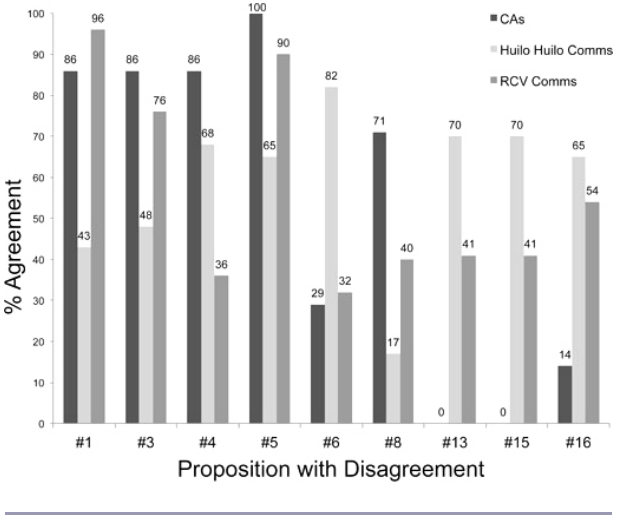
Fig. 1 . Percent agreement with propositions that have disagreement by at least one group. (CA = conservation agents, HH = Huilo Huilo Reserve communities, RCV = Valdivian Coastal Reserve